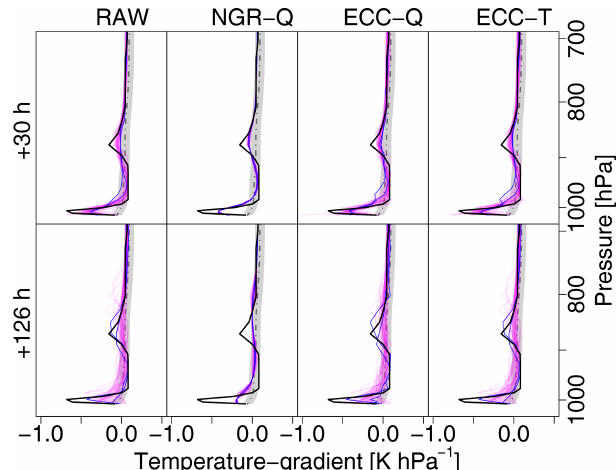
Figure 8. Observation (black bold solid) and forecasts (magenta) of the vertical temperature gradient for the 6 December 2016, 06:00Z winter case. Top row is for lead time + 30h and bottom row for + 126h. Columns show (from left to right) raw ensemble, univariate NGRVC-Q, multivariate ECC-Q and multivariate ECC-T. The same two particular members are highlighted in blue in all the subfigures. Note that a negative temperature gradient in pressure coordinates means an increase in temperature with